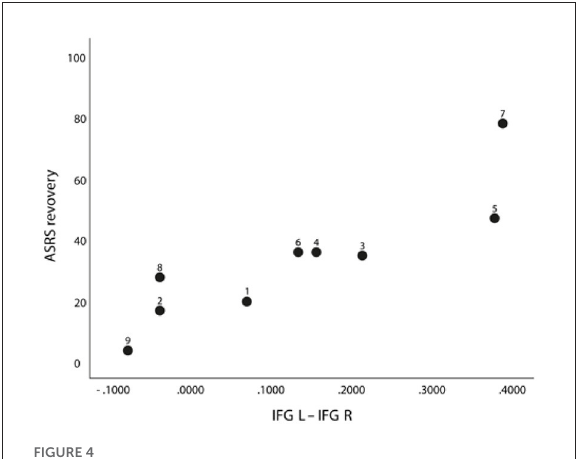
FIGURE4 Correlation between ASRS recovery and FC between left and right IFG at A1 (rho = 0.92 , p = 0.001/ q = < 0.003) in nine participants with AOS (with participant ID